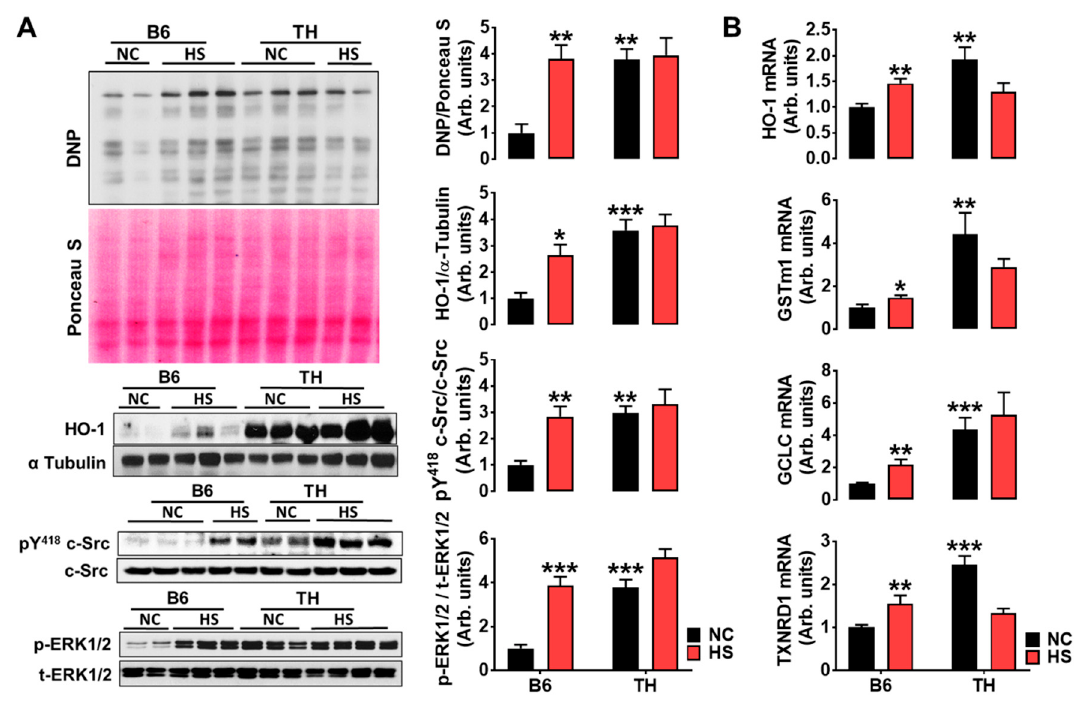
Figure 5. TH mice encounter dysregulation of Na / K-ATPase signaling. ( A ) In the kidney cortex tissues, reactive oxygen species (DNP: n = 5–10; HO-1: n = 9–12) and c-Src ( n = 6–8) and ERK1 / 2 ( n = 6–12) phosphorylation were activated, but not stimulated by HS diet in obese TH mice, in comparison to wild-type B6 mice. Left panel, representative Western blots. Right panel, quantitative analysis. ( B ) qRT-PCR analysis of nuclear factor erythroid 2-related factor 2 (Nrf2) target genes in the kidney cortex tissues. GSTm1, glutathione S-transferase M1. GCLC, glutamate-cysteine ligases. TXNRD1, thioredoxin reductase 1. * p < 0.05; ** p < 0.01; *** p < 0.001 versus B6 NC. HS, 7 days of 2% NaCl, 7 days of 4% NaCl, and then 7 days of 8%